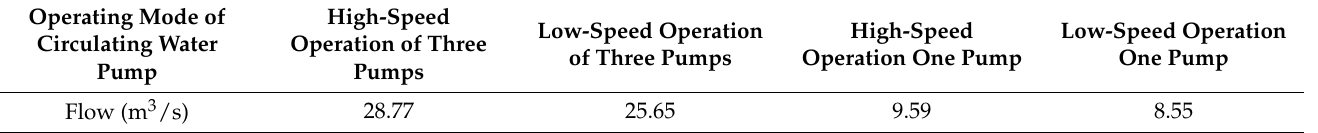
Table 1. Circulating pump operation condition